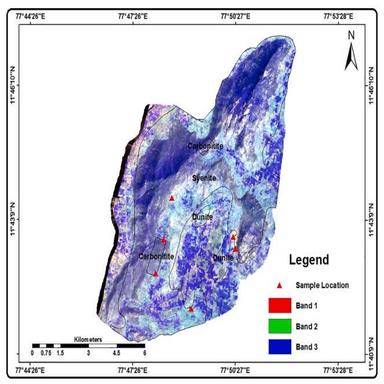
True color composite image of Pakkanadu Carbonatite Complexes generate using ASTER band 1, 2, 3 in RGB and the carbonatite in bulrred blue color, syenite in dark blue color and dunite in white color.